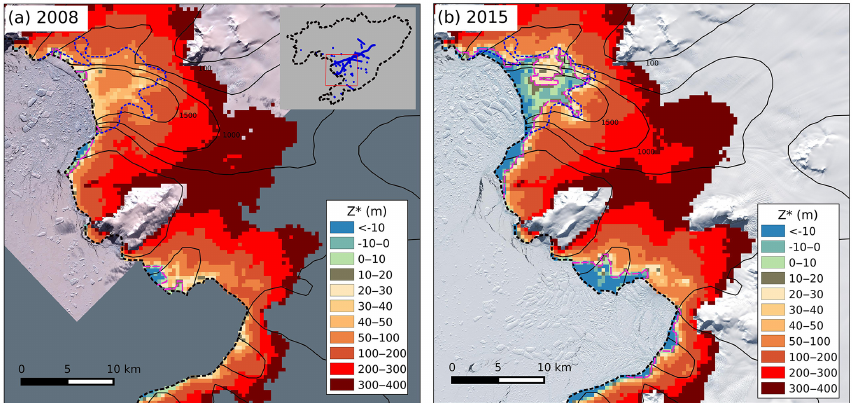
Figure 6. The height above buoyancy Z ∗ in (a) 2008 and (b) 2015 of the Fleming Glacier and Prospect Glacier. The background images are from (a) ASTER L1T data in 2 February 2009 and (b) Landsat-8 in 13 January 2016, respectively. The black lines represent velocity contours in 2008 (Rignot et al., 2011b). The dashed black and blue lines show the grounding line in 1996 (Rignot et al., 2011a) and 2014 (Friedl et al., 2018), respectively. The dashed magenta line shows the possible grounding line with Z ∗ < 20m. Inset map shows the location in the research domain with blue points showing the available elevation data points used to extract the hypsometric model of elevation change from 2008 to 2015 (Zhao et al.,